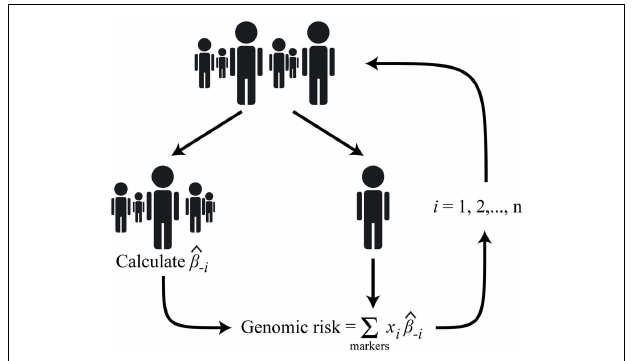
FIGURE 2 | Diagram of the n -fold cross-validation approach used to calculate the BHS genomic risk scores; where i is the index corresponding to the i th subject, ˆ β − i is the marker effect calculated after excluding the i th subject, and x i is the genotype (additive coding) of the i th